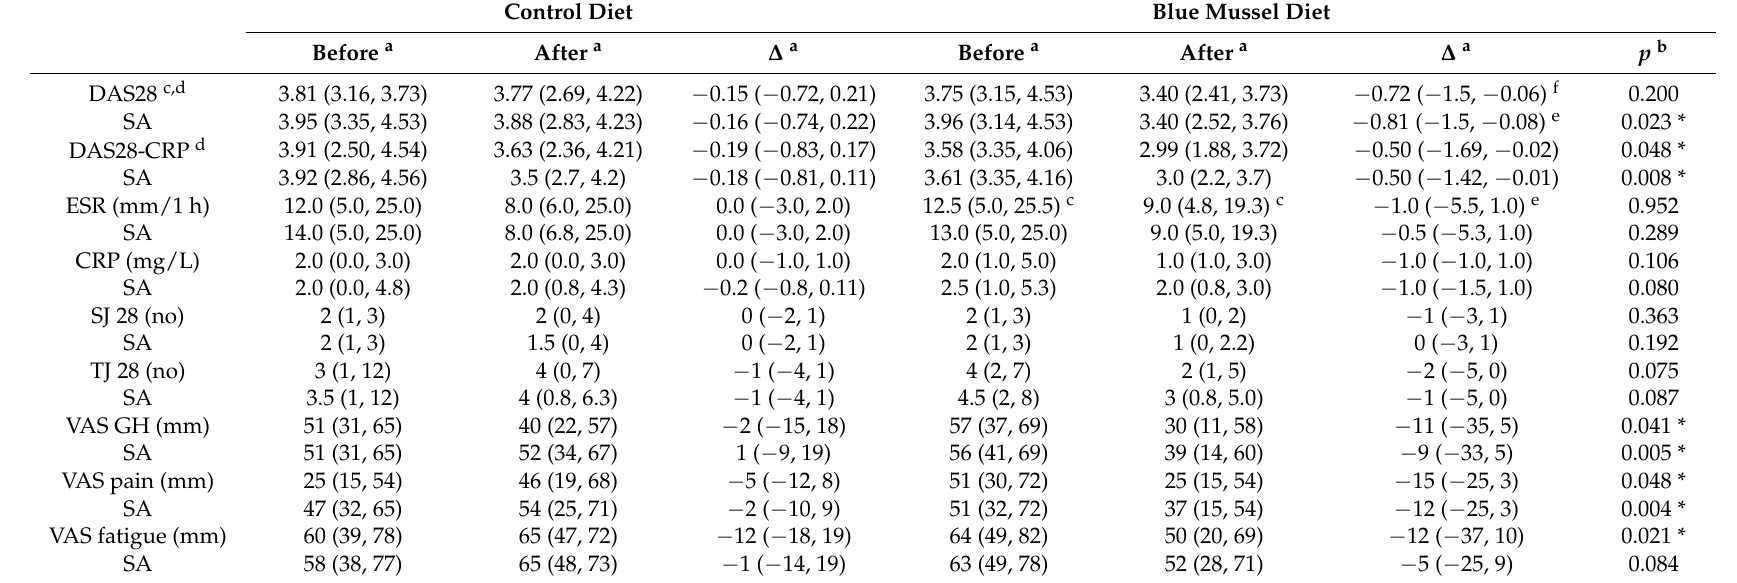
Table 4. Blue mussel diet versus control diet on disease